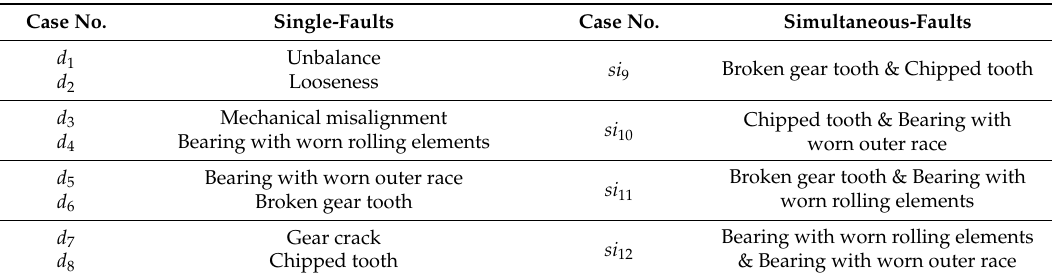
Table 4. Description of single-faults and simultaneous-faults.